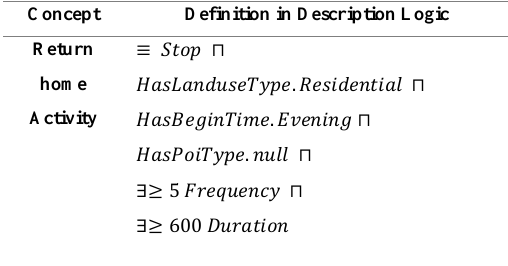
Table 2. Definition of home activity ontology